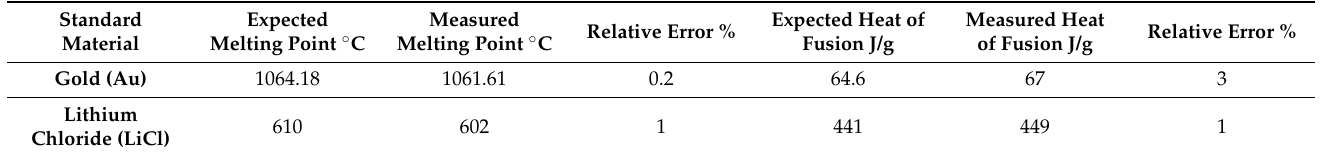
Table 3. Calibration of STA using gold and individual testing of lithium